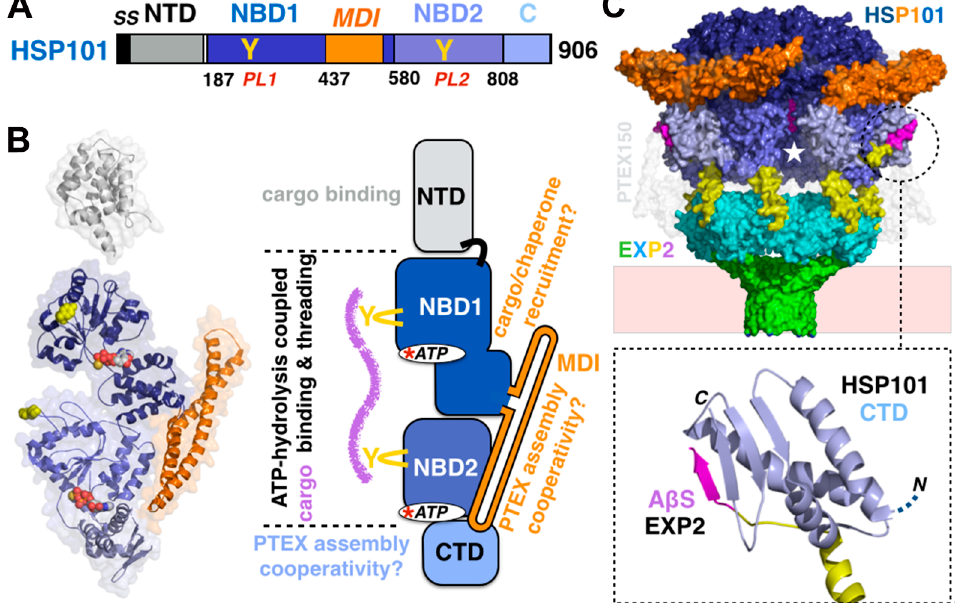
Figure 5. The hexameric AAA+ protein unfoldase HSP101/ClpB2 and its interactions with the PTEX150/EXP2 tetradecamer. ( A ) Domain organization of HSP101/ClpB2. ( B ) Structure of the HSP101 protomer with domains colored as in (A), tyrosine pore loops (yellow) and ATP molecules (atom spheres). The cryo-EM structure of the HSP101 lacks the N -terminal domain whose crystal structure was solved separately [60] . The schematic indicates the activities and functions of each domain. (C) Six-to-seven symmetry mismatched assembly of the hexameric HSP101 on the C7 symmetric PTEX150/EXP2 tetradecamer PTEX150 is rendered in transparent light grey to emphasize the direct interactions between HSP101 and EXP2. Endogenous cargo (magenta spheres) is present in the HSP101 central translocation pore (white star). The inset details the β -augmentation anchoring the CTD of HSP101 to the C- terminal assembly β -strand of EXP2 (colored as in Figure 3).